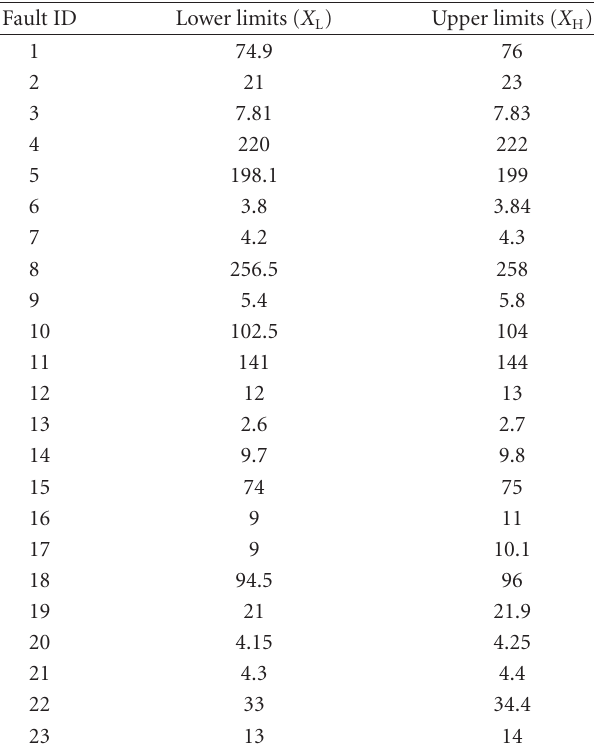
Table 8: Fault bounds.